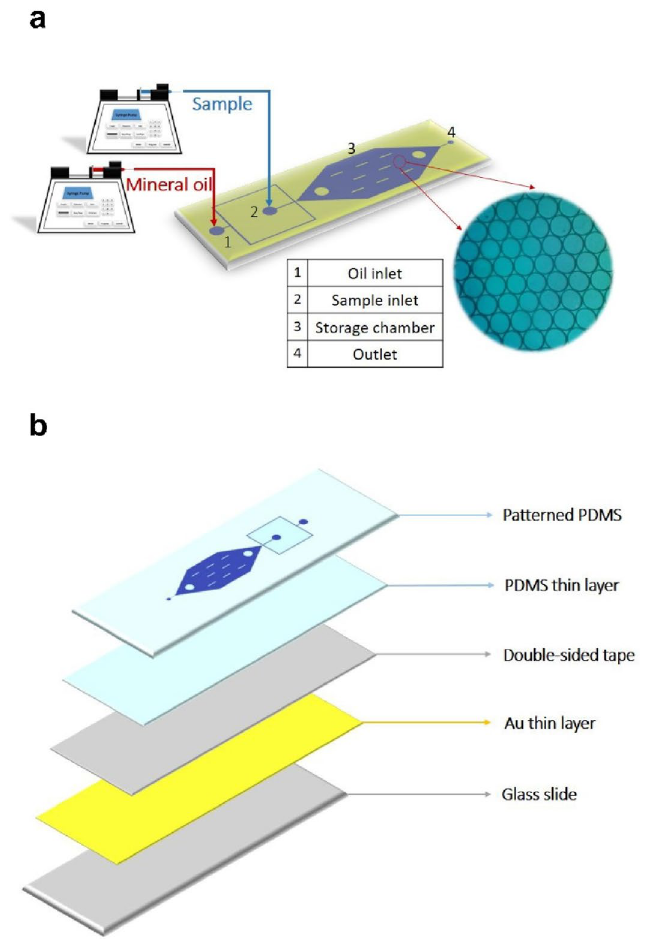
Figure 1. ( a ) Layout of the manufactured microfluidic chip for droplet generation and trapping: two syringe pumps are applied at the inlets, which control sample and oil flow rates to generate monodisperse droplets. ( b ) Illustration of the layered chip structure composed of a patterned PDMS layer, a partially cured PDMS thin layer, a double-sided tape layer, an AuNF layer, and a glass substrate